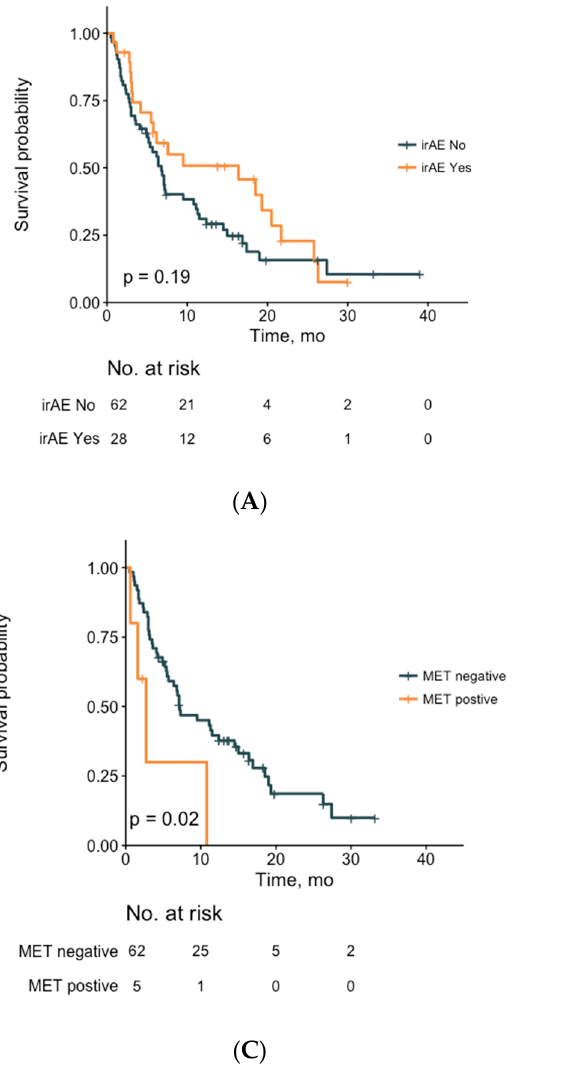
Figure 3. Clinical and molecular features with OS. ( A ) OS with irAEs, ( B ) interruption of ICIs due to irAEs, ( C ) genomic alterations in MET , and ( D ) FANCA . Log-rank (Mantel–Cox) tests were used to compare the survival curves. Data visualization and statistical analysis were performed with R.